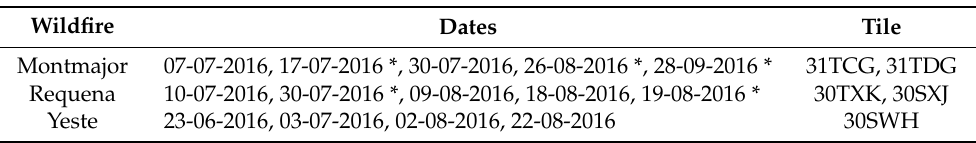
Table 3. Selected Sentinel-2 cloud-free images for the three wildfires and their surrounding areas used for generating the